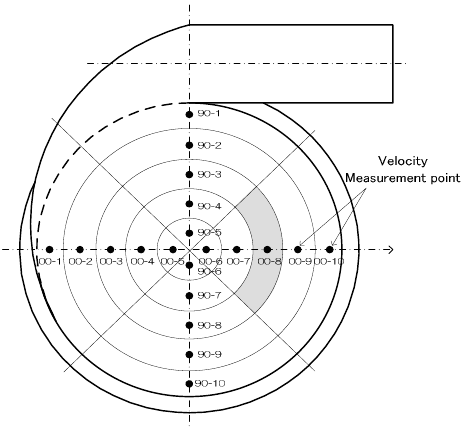
Fig. 9 : Representation of method adopted for flux calculation